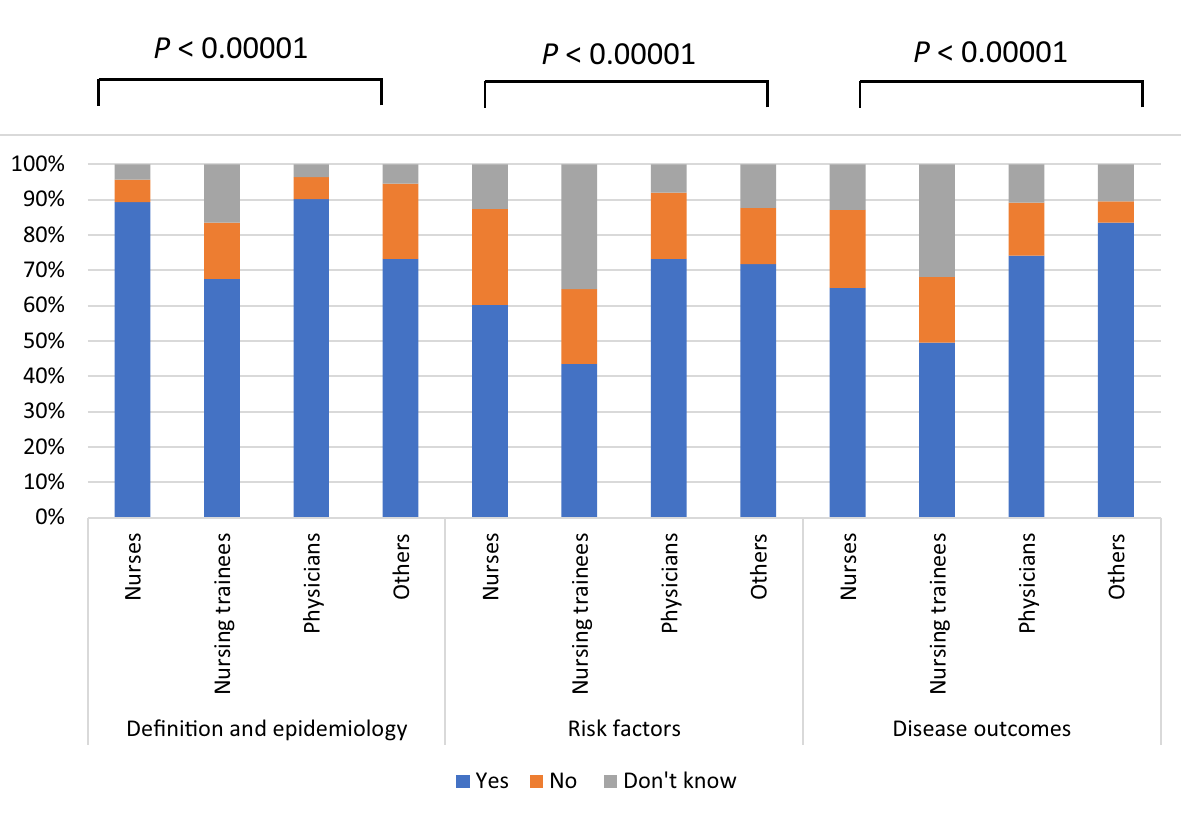
Figure 1. Self-assessment by areas of knowledge. Data are presented divided into three categories: general knowledge (questions 1–4 and 14), knowledge about risk factors (questions 5–10) and knowledge about disease outcomes (questions 11–13) (see Table 2 for the